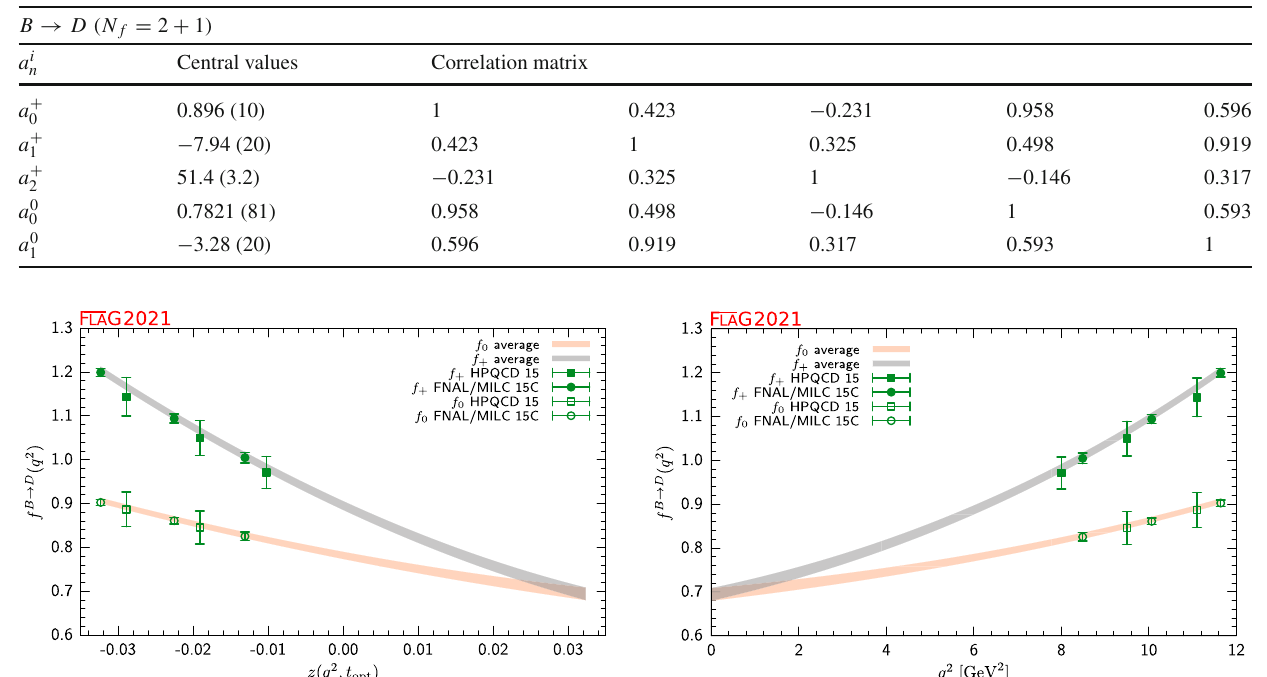
Table 52 Coefficients and correlation matrix for the N + = N 0 = 3 z -expansion of the B → D form factors f + and f 0 . The chi-square per degree of freedom is χ 2 / dof = 4 . 6 / 6 = 0 . 77. The lattice calculations that enter this fit are taken from FNAL/MILC [606] and HPQCD [607]